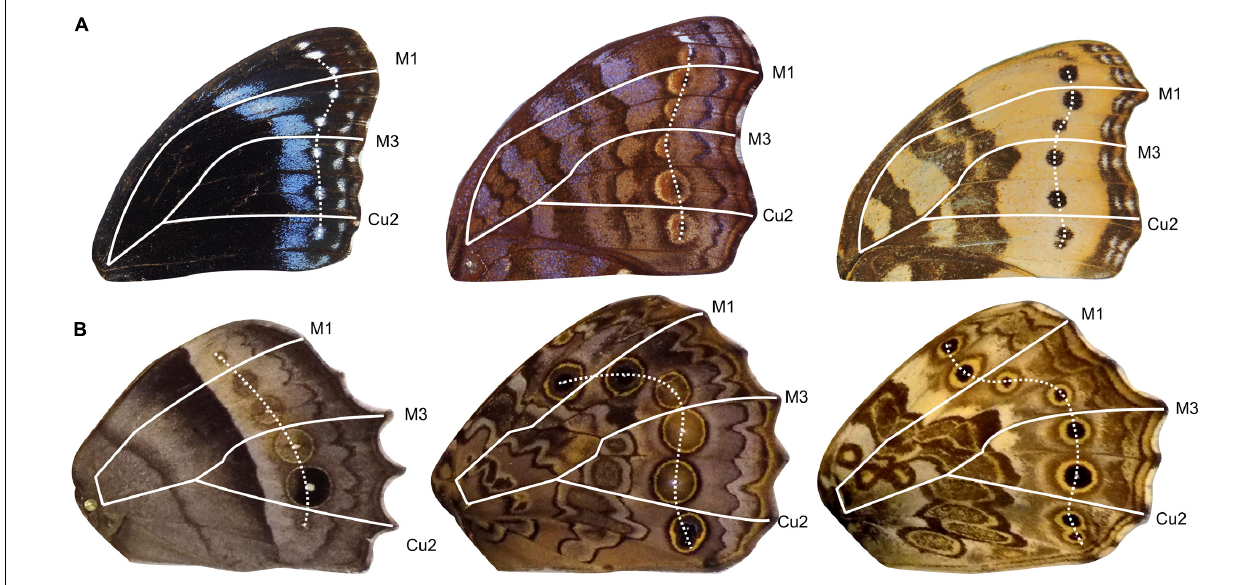
FIGURE 4 | Example of forewing and hindwing dislocation of border ocelli. Forewings in panel (A) show different patterns of ocelli dislocation. Hindwings in panel (B) show different degrees of dislocation. Veins are outlined to represent boundaries between expression domains. Ocelli are connected by white dashed